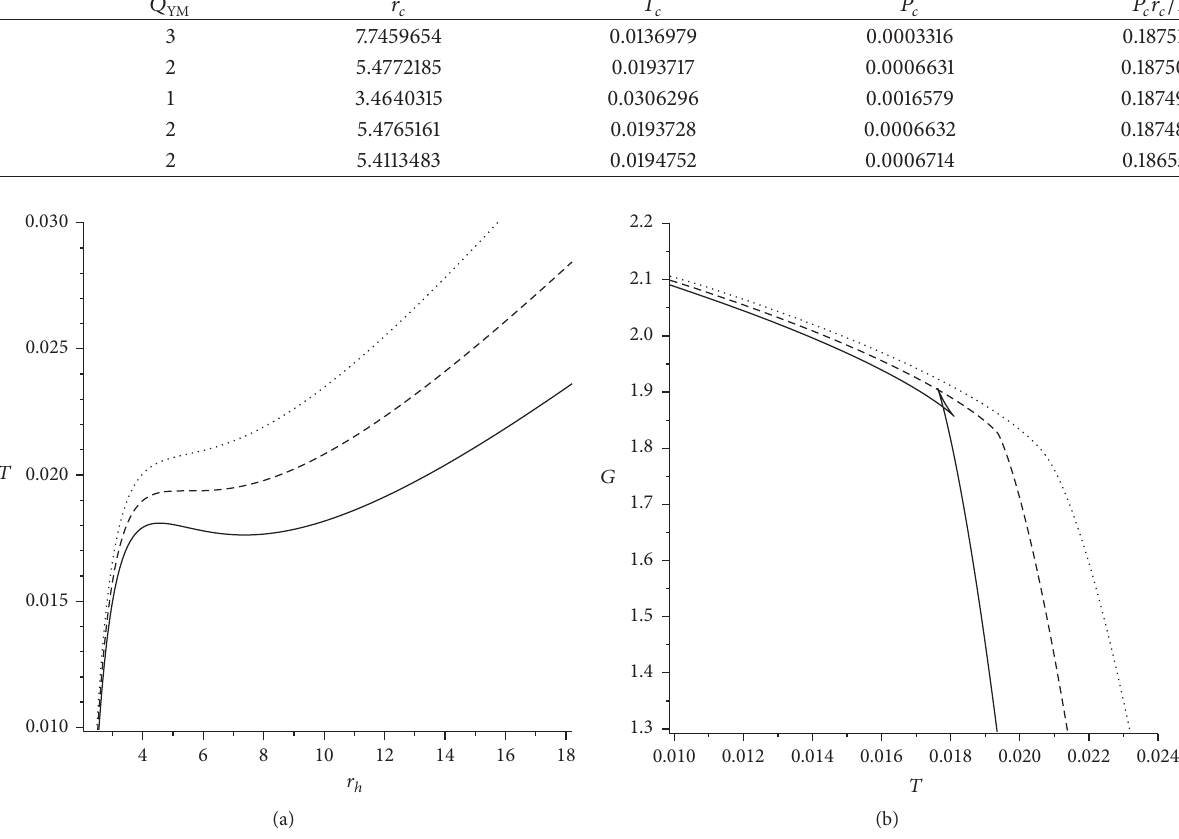
𝐺 - 𝑇 plot are in one-to-one correspondence with each + plot and